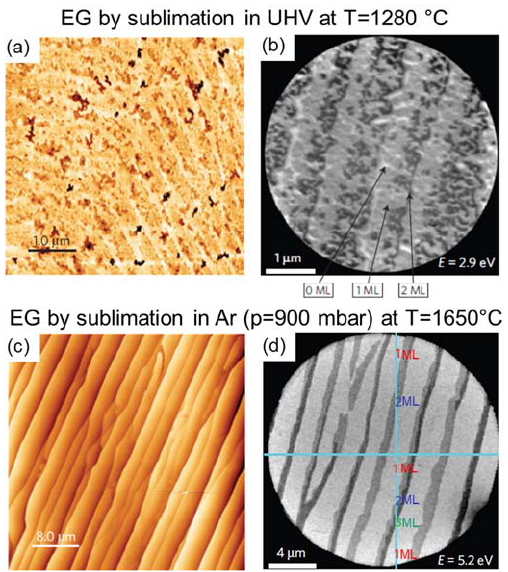
Figure 2. ( a ) Atomic force microscopy (AFM) morphology and ( b ) low energy electron microscopy (LEEM)mapofEGgrownon6H–SiC(0001)bysublimationinultra-high-vacuum(UHV)atatemperature T = 1280 ◦ C. ( c ) AFM morphology and ( d ) LEEM map of EG on 6H–SiC(0001) obtained by sublimation in Ar ambient at atmospheric pressure (p = 900 mbar) and at a temperature T = 1650 ◦ C. Darker LEEM contrast corresponds to a larger number of graphene layers. Images adapted with permission from Ref. [21], Copyright Nature Publishing Group 2009. Appl. Sci. 2020 , 10 , x FOR PEER REVIEW